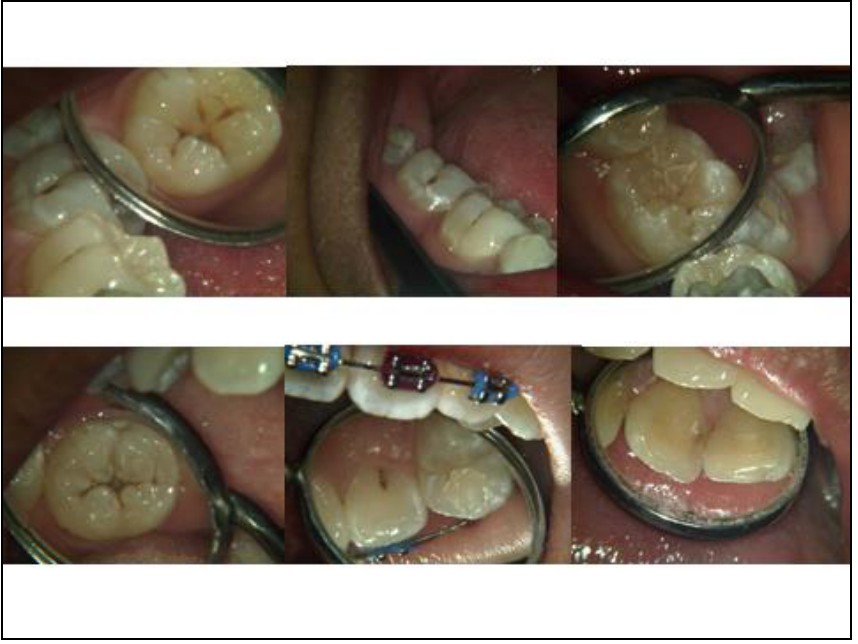
Figure 3. Camsight digital images of patients’ teeth depicting different ICDAS codes.